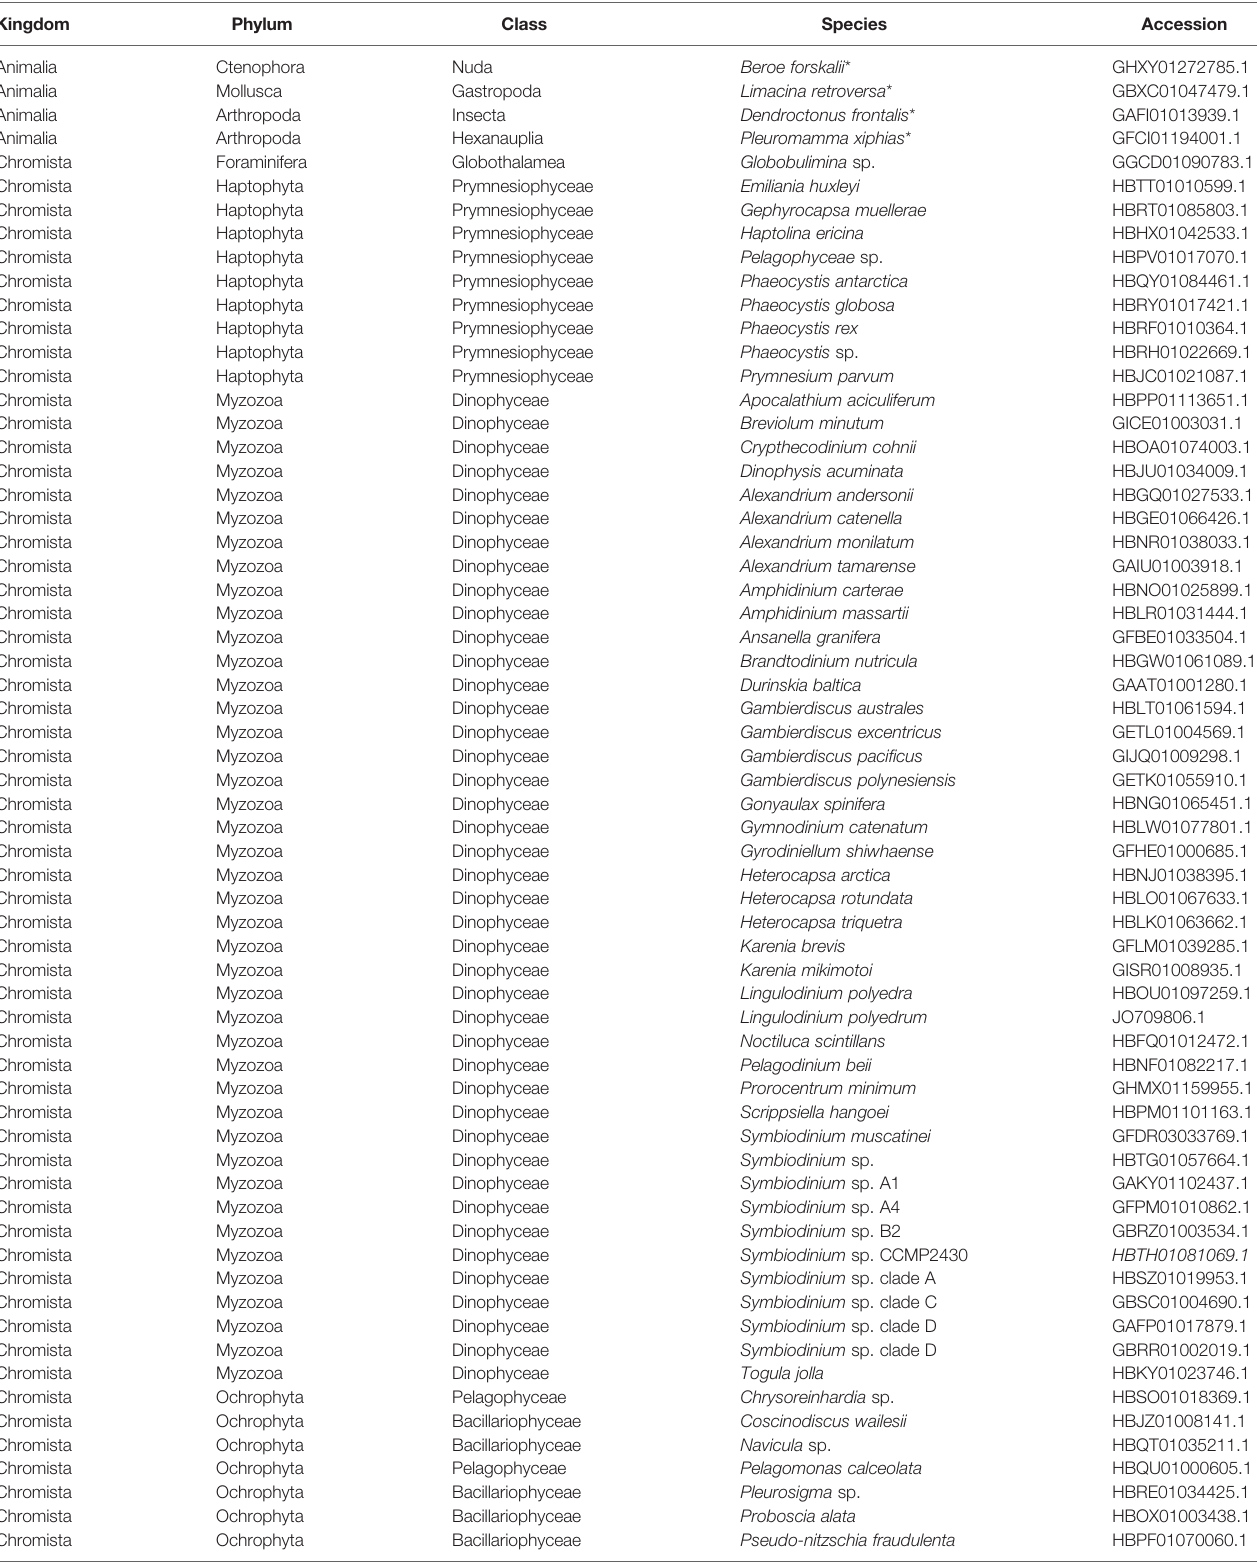
TABLE 1 | DL-L genes in Eukaryotes, excluding those from